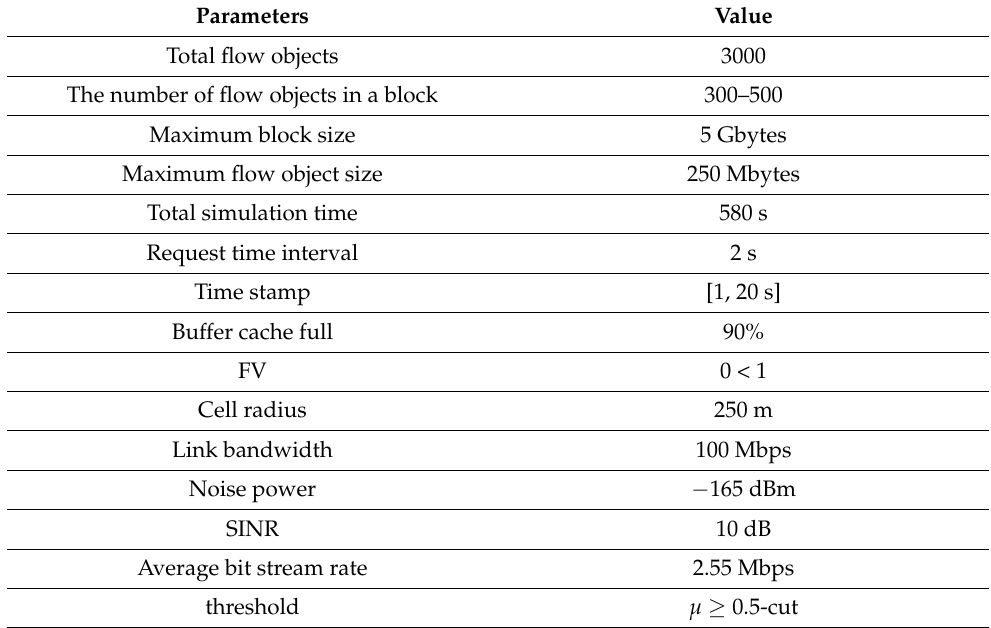
Table 1. Simulation